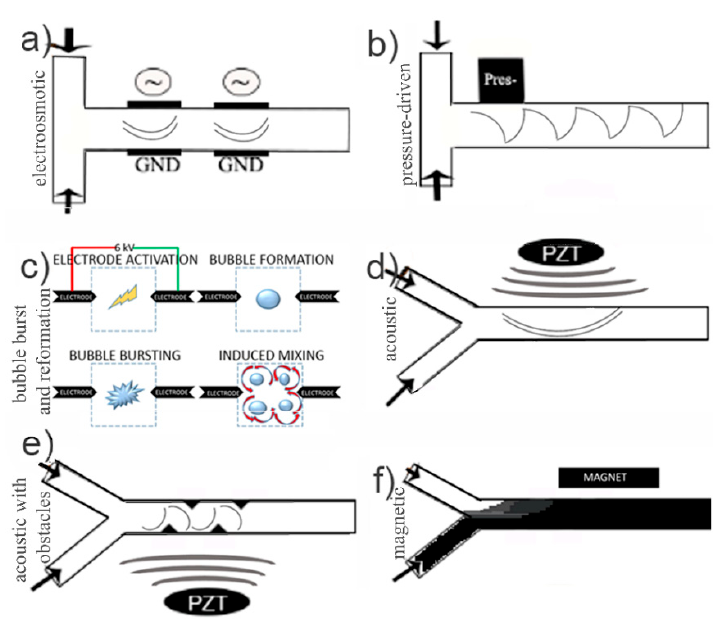
Figure 2. Active micromixing designs. ( a ) An electroosmotic micromixer with two electrode pairs. ( b ) A pressure driven microfluidic mixer. ( c ) The bubble burst-and-reformation based mixer, reproduced with permission from [69], published by Springer Nature, 2017. ( d ) Acoustic active micromixing. ( e ) Synergetic passive and active mixing mechanism. Solid triangular shaped blocks added in the path stream to contribute to an active mixer such as electroosmotic or acoustic. ( f ) Magnetic mixing with ferro fluids. Table 1. Comparison of the different mixing mechanisms.